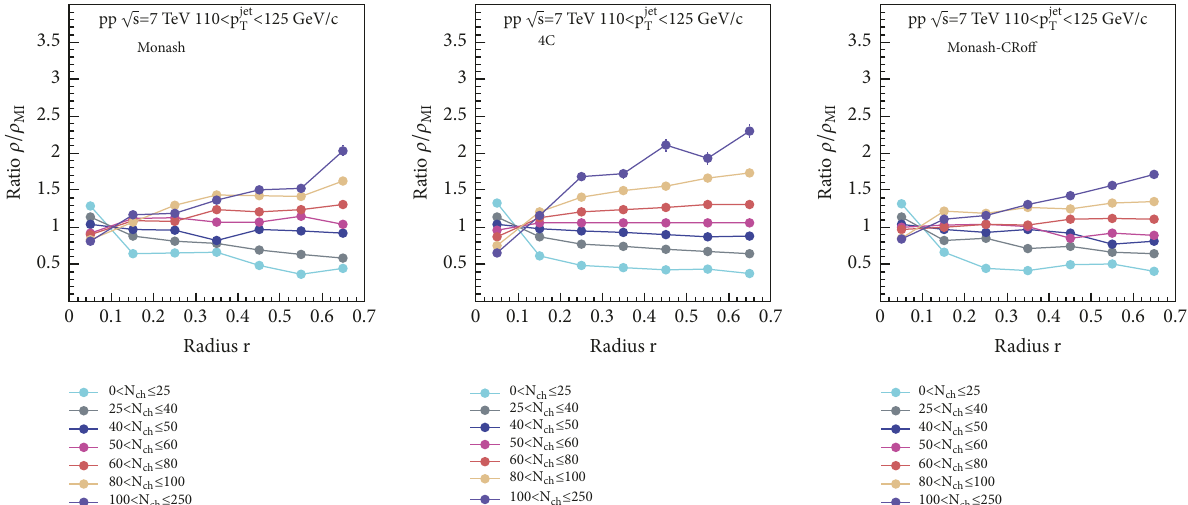
Figure 6: Ratio 𝜌/𝜌 of differential jet structure in several multiplicity classes (see legend) over multiplicity-integrated events, for jets within MI < 125 GeV /𝑐 window. In the left hand side, central and right panels show events generated using the Monash tune, the the 110 GeV /𝑐 < 𝑝 jet T 4C tune, and the Monash tune without CR,